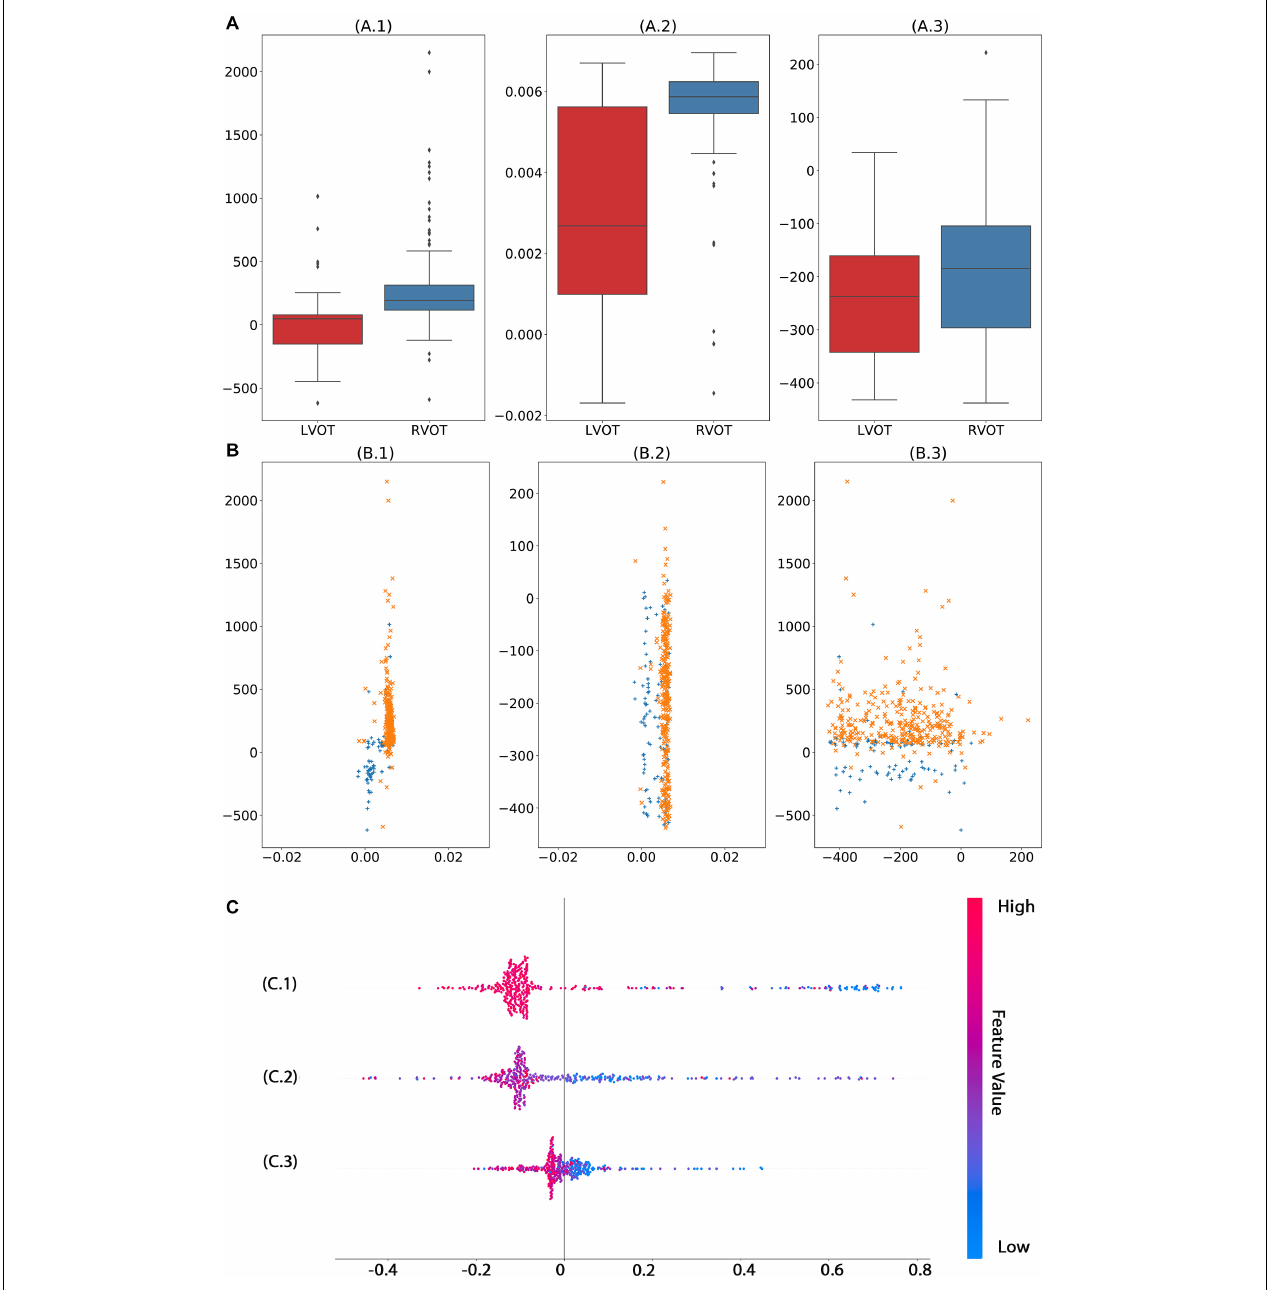
FIGURE 6 | Analysis of top three significant ECG measurements found by machine learning model with automated feature extraction method. The univariate analysis (A) shows that features 1 (A.1) and 2 (A.2) have significant capability to separate RVOT and LVOT. The bivariate analysis (B) indicates the classification ability of one–one interaction of the top 3 significant features. In the multivariate analysis (C) , the smaller feature 1 (C.1) , feature 1 (C.2) , and feature 3 (C.3) generate a higher probability of LVOT, but the magnitude of influence varies across features. The color in panel (C) represents the feature value (red high, blue